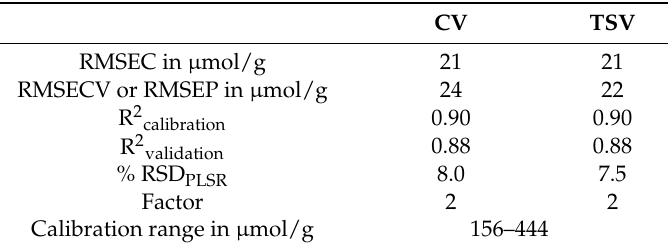
Figure 3. Regression coefficients plot (Factor 2) of the established PLSR model. Table 1. Parameters of the established PLSR model.